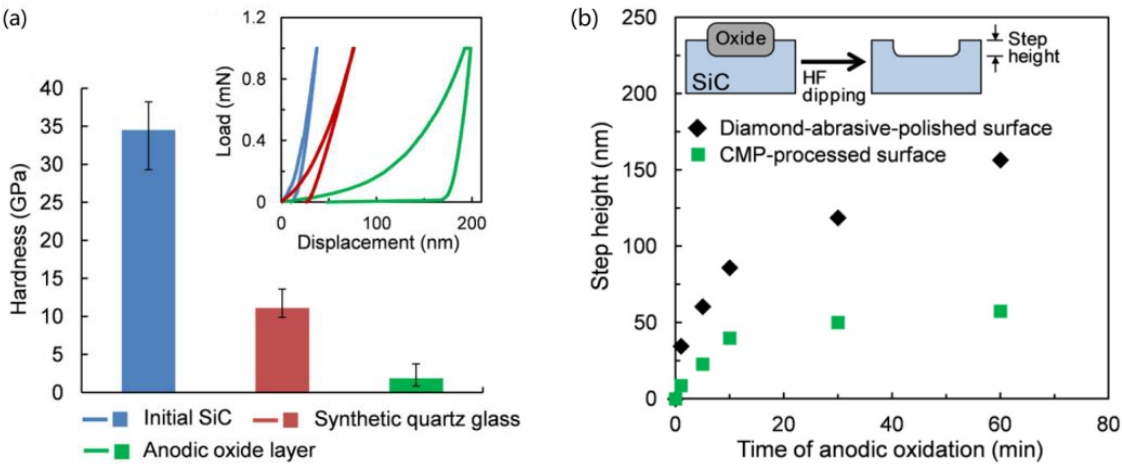
Figure 23. ( a ) Hardness measured by the nanoindentation method, ( b ) thickness of anodically oxidized SiC with different durations [15].